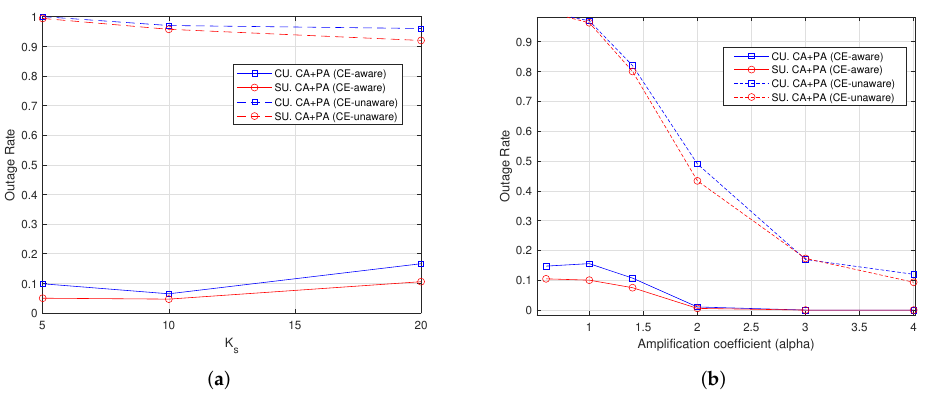
Figure 7. Outage rate with F = 1, K c = 30 users, 100 iterations. ( a ) Varying K s , α = 1; ( b ) varying α , K s = 10.